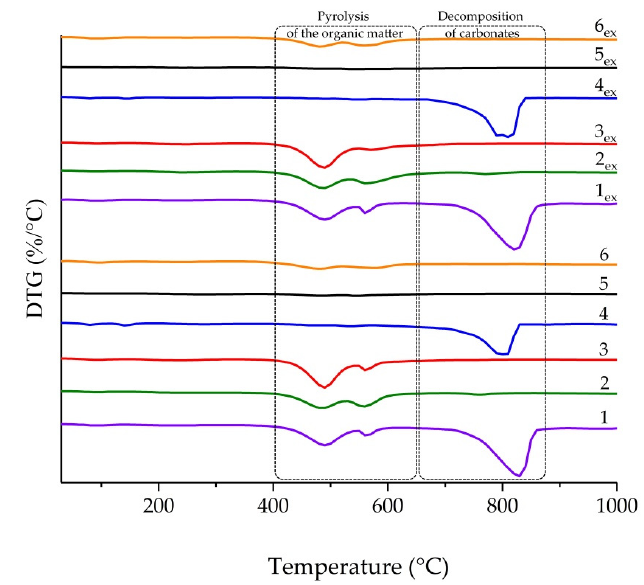
Figure A3. Comparison of DTG curves for rock samples before (1–6) and after (1 ex –6 ex ) bitumen extraction (TGA measurement under inert atmosphere).